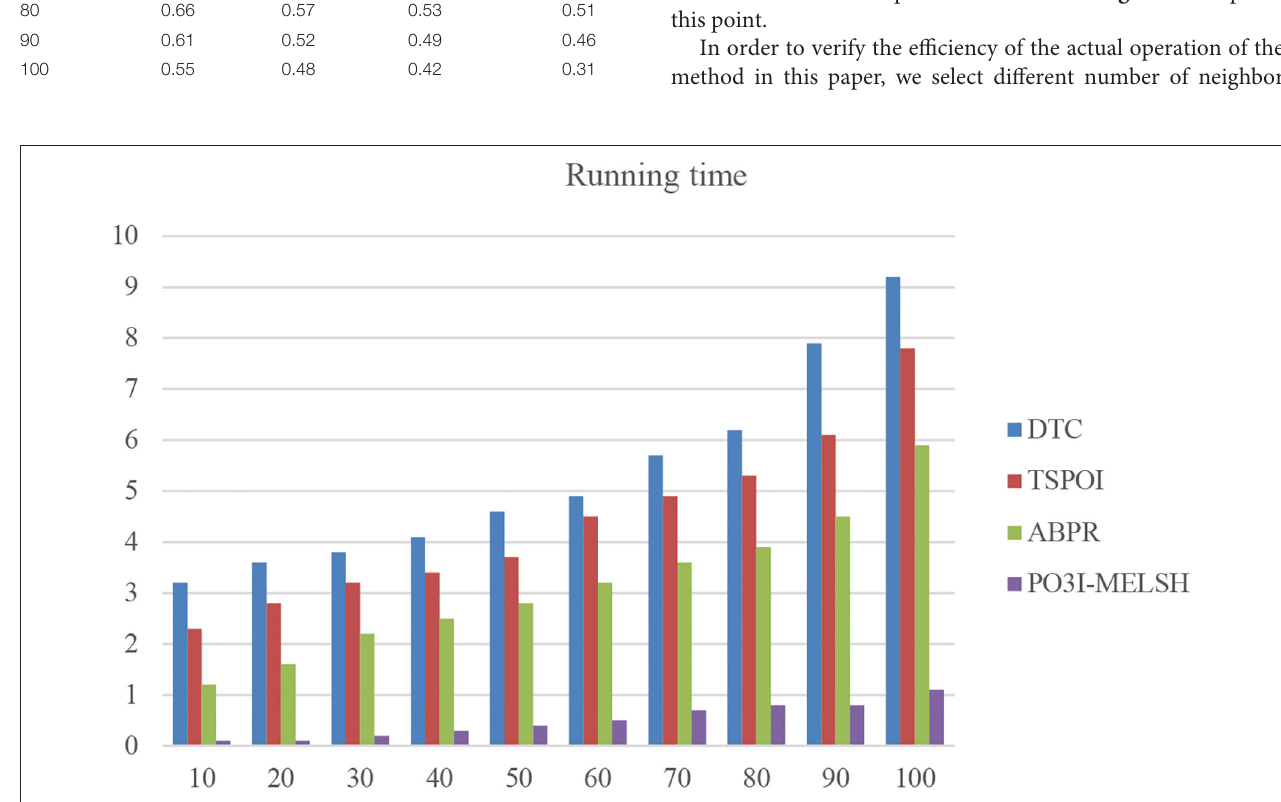
FIGURE 9 | Running time comparison with different